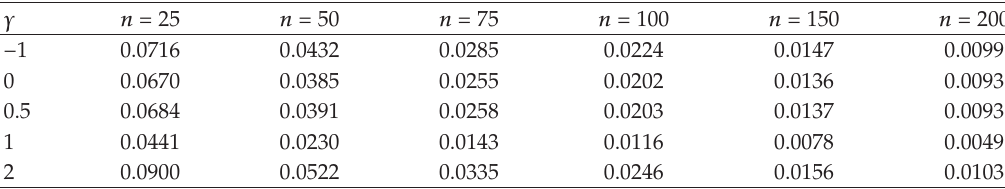
Table 2: MSE of the estimates for the normal distribution, B (cid:6) 1000.